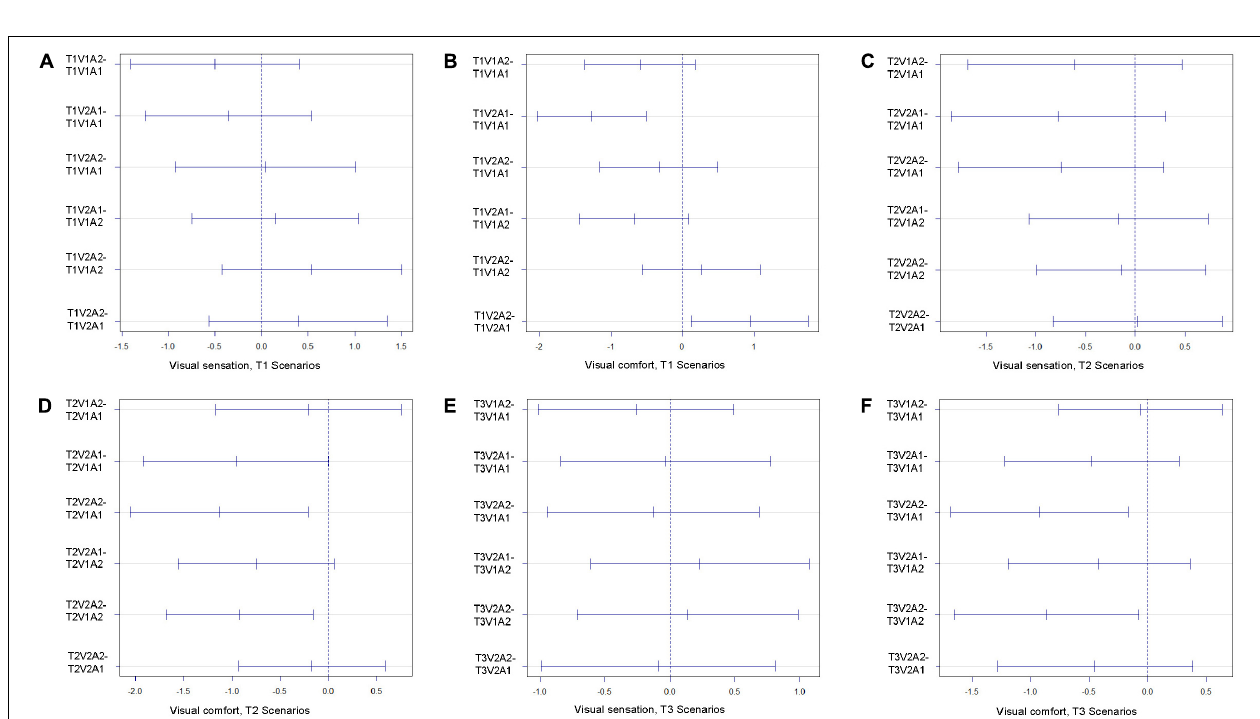
FIGURE 7 | Differences in mean levels of visual sensation (A) and comfort (B) votes in T1 Scenarios, visual sensation (C) and comfort (D) votes in T2 Scenarios, and visual sensation (E) and comfort (F) votes in T3 Scenarios.